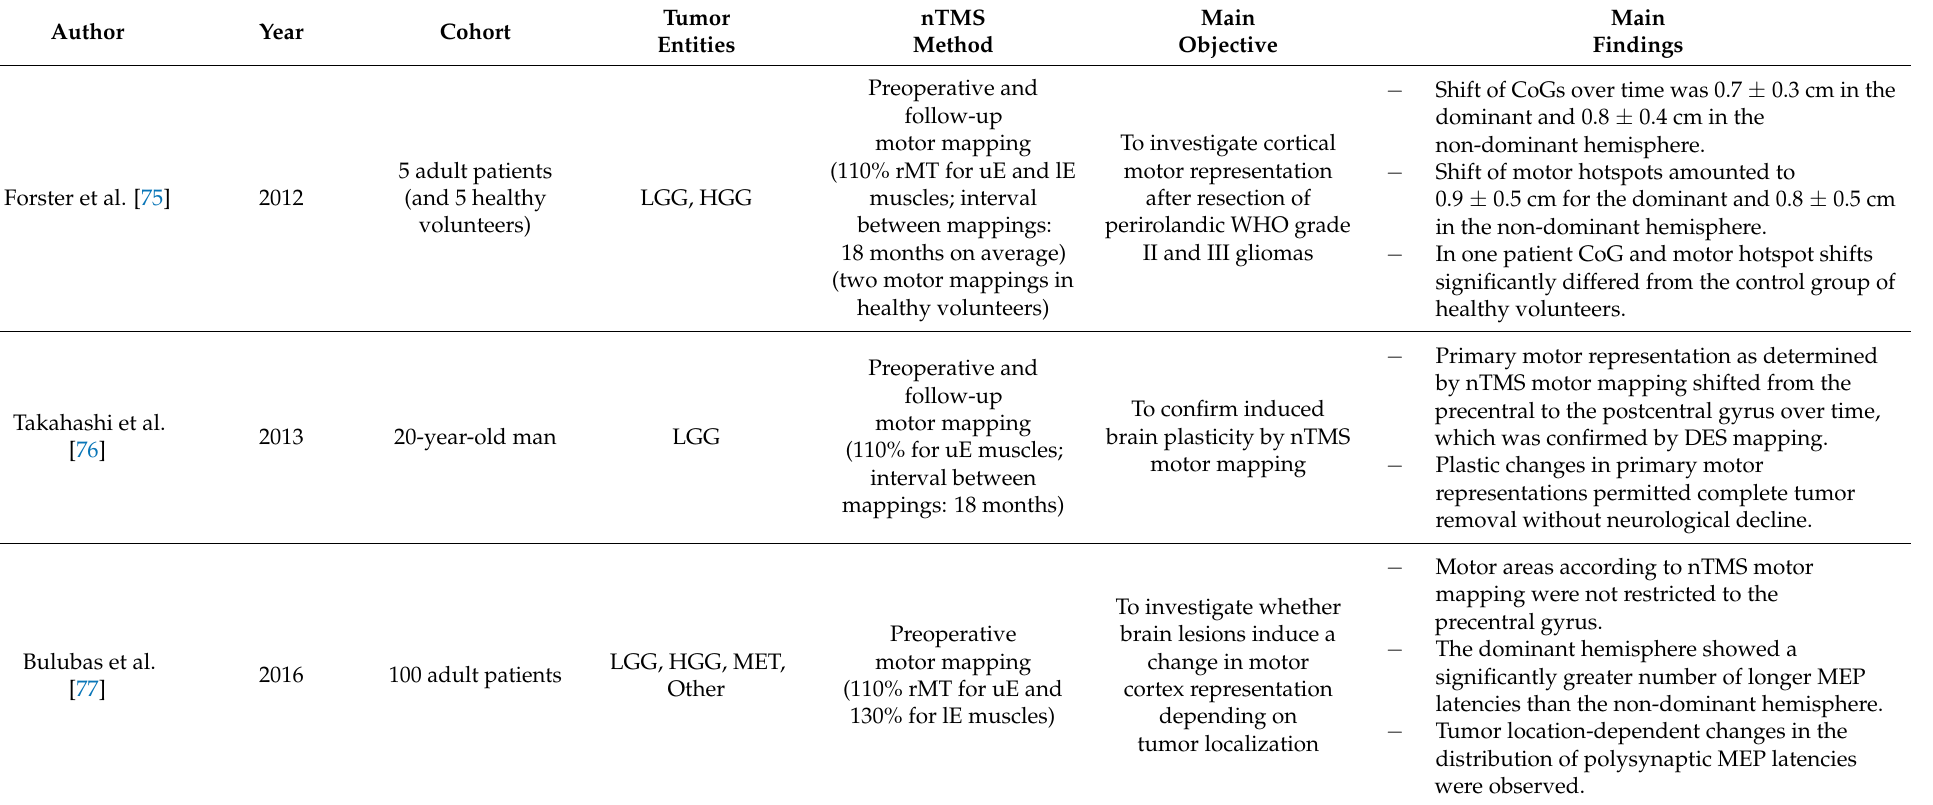
Table 5. Plasticity and reallocation of motor function. This table outlines the studies published on plasticity and reallocation of motor function as revealed by motor mapping using nTMS (using an electric-field-navigated system) with or without additional nTMS-based tractography in patients harboring brain